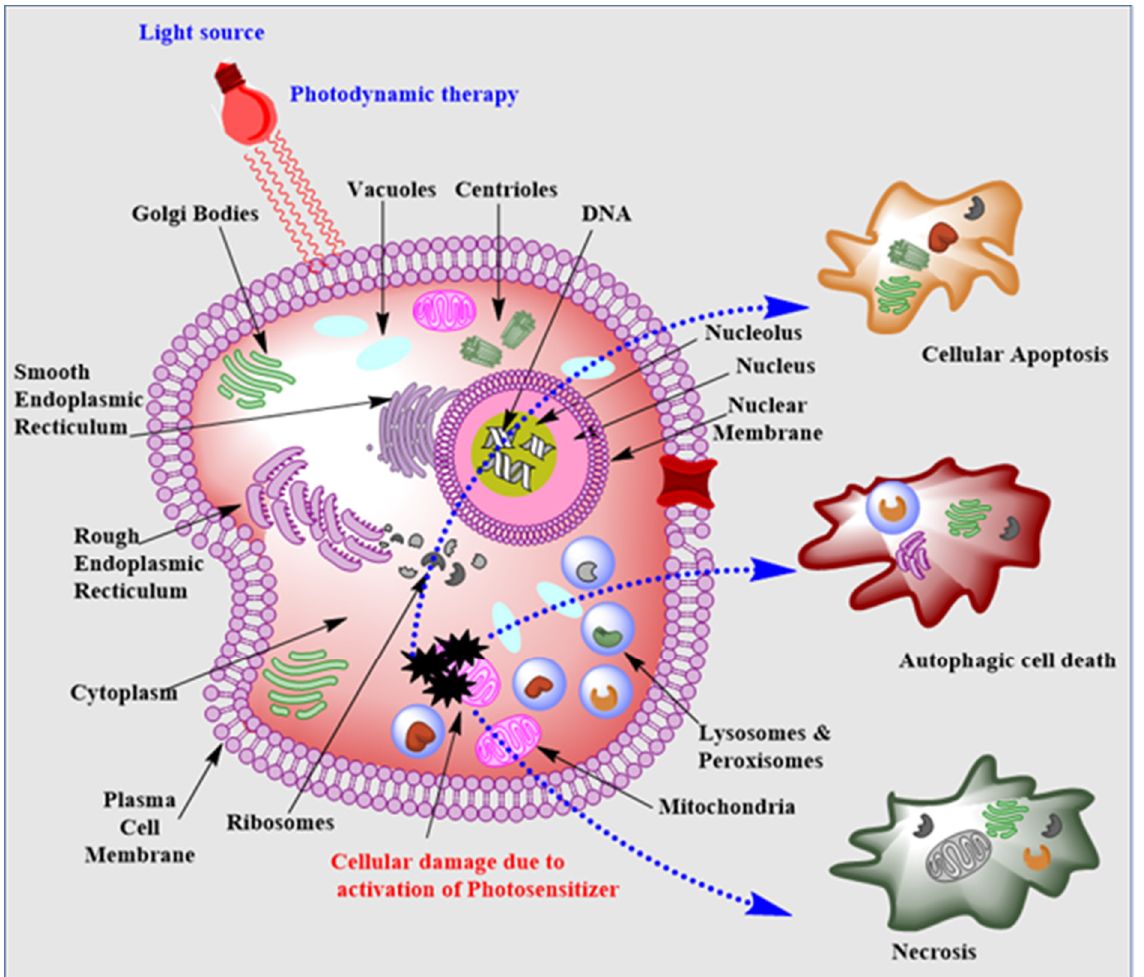
Figure 2. All the cellular organelles are depicted in this image. Upon irradiation, the PS molecules become activated and result in phototoxicity or death to the tumor tissue or cells through different mechanisms such as apoptosis, autophagy, and necrosis, depending on the internalization and localization of PS molecules into tumor tissues.